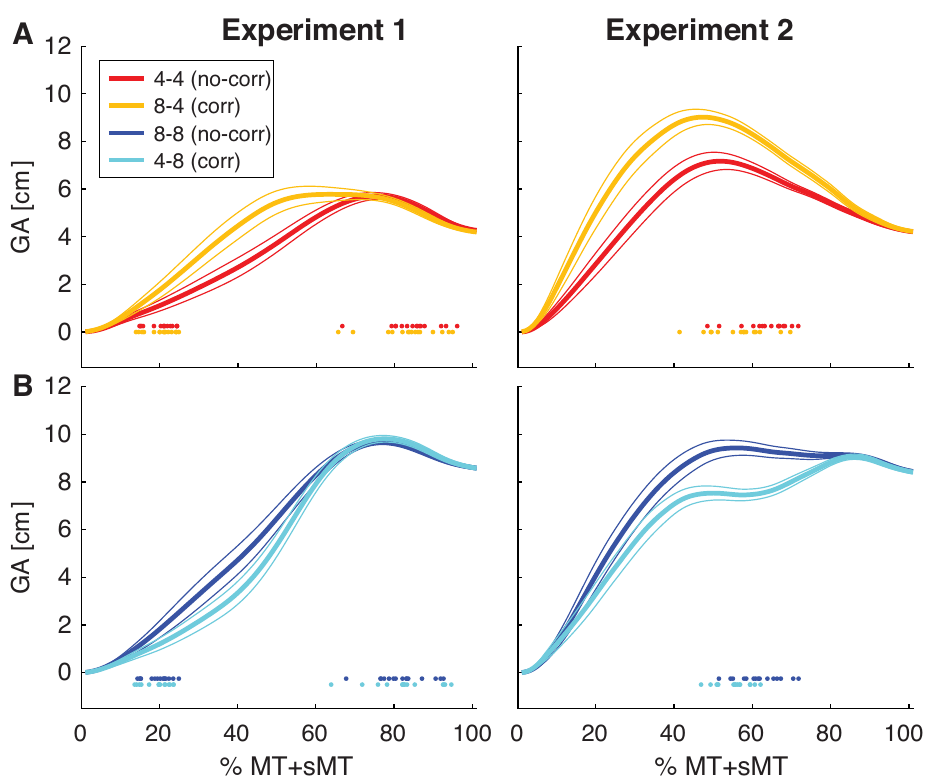
Fig 4. Grip aperture (GA) profiles. (A): Grasping a small object with a small preview (red lines: no-correction small 4–4) or large preview (yellow: correction small 8–4). (B): Grasping a large object with a large preview (blue: no- correction large 8–8) or small preview (cyan: correction large 4–8). Curves are plotted against the relative time from movement onset to the starting of the lifting movement, including both movement time (MT) and secondary movement time (sMT). Thick lines indicate average curves across participants, thin lines represent standard errors. Coloured dots early in the movement represent individual time points the glasses opened in Experiment 1. Coloured dots late in the movement represent the individual time points of the start of the secondary movement. These curves were used to calculate the summed grip aperture.